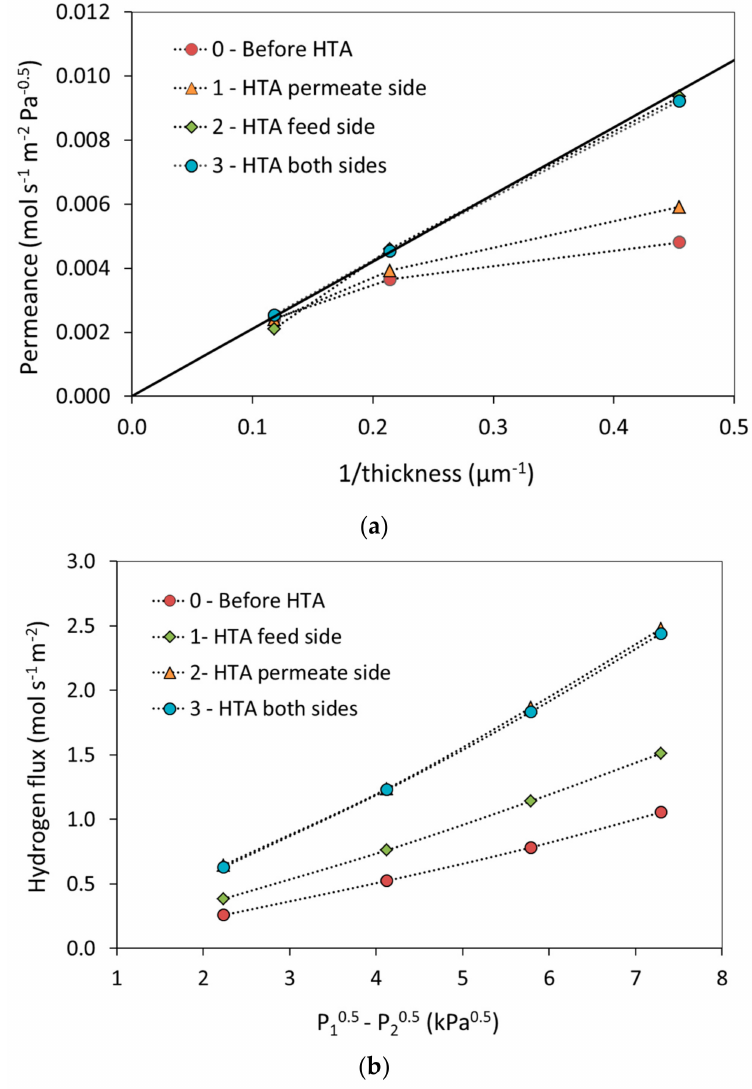
Figure 3. Permeance measured at 300 ◦ C for each single step of heat treatment in air; ( a ) as function of inverse thickness for the main HTA membrane side sequence with the full line indicating a permeability of 2.1 × 10 − 8 mol · s − 1 · m − 2 · Pa − 0.5 , and ( b ) as function of the difference in the square root of the hydrogen partial pressure for the HTA2 membrane side sequence applied to a 2.2 µ m thick